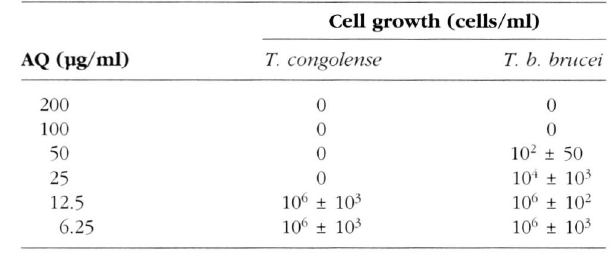
Table I. - Trypanocidal activity of azanthraquinone extract (AQ) on T. congolense and T. b. brucei.